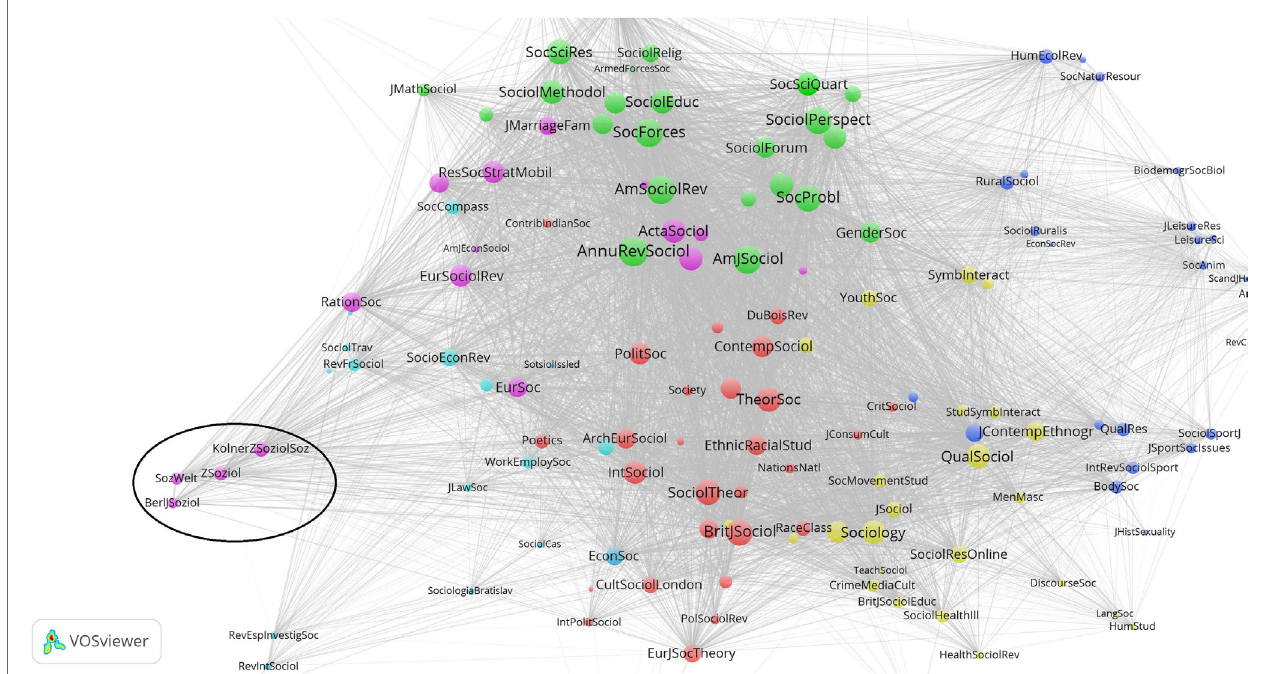
FigUre 1 | Four german sociology journals among 141 journals classified as “sociology” in the Web-of-science (Jcr 2014), mapped in terms of their (cosine-normalized) being cited patterns using VOsviewer for the mapping and the classification